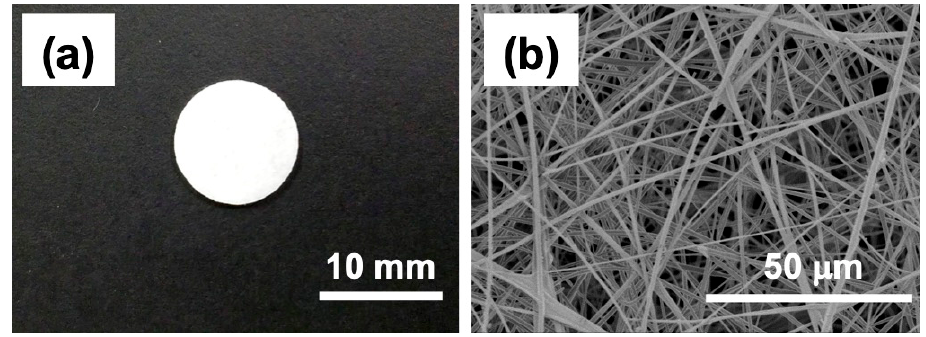
Figure 2. Macroscopic ( a ) and scanning electron microscopic ( b ) images of silica nonwoven fabrics.